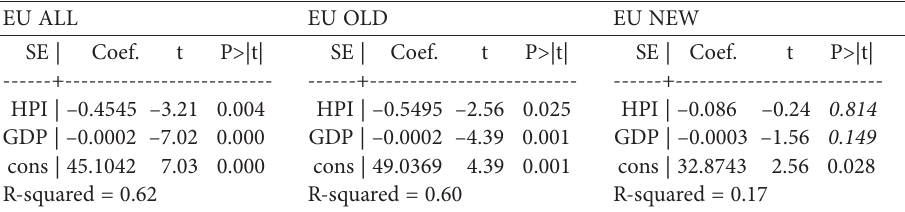
Table 12. Models for EU ALL, EU OLD and EU NEW EU ALL EU OLD EU NEW SE |